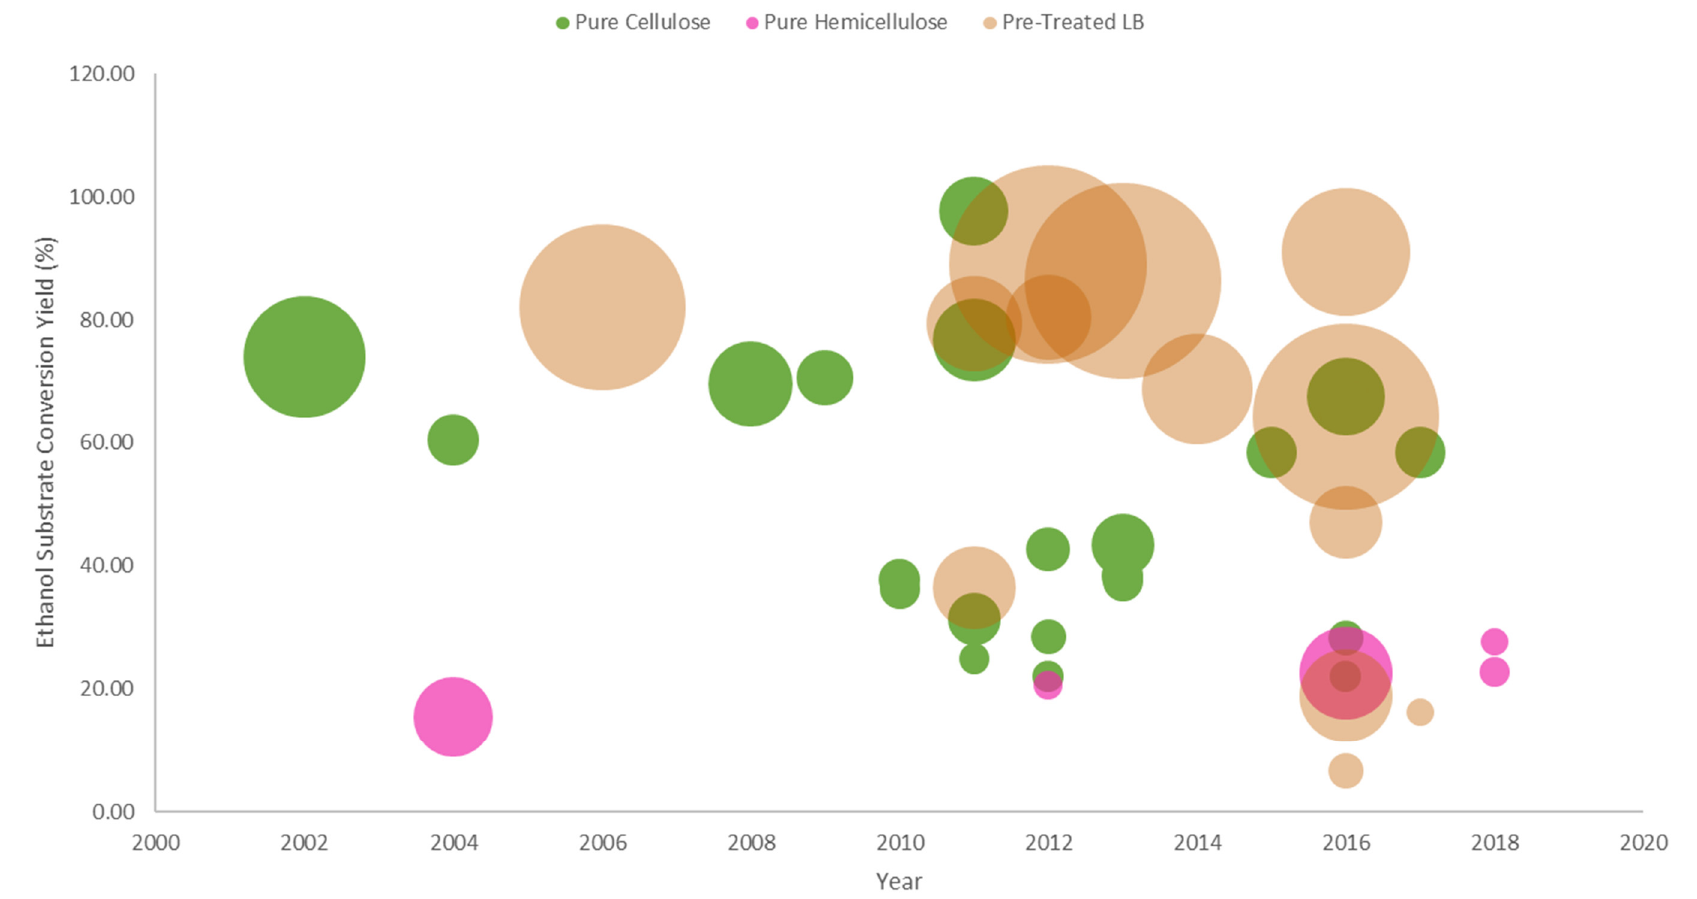
Figure 9. Visualization of the status and development of yeast surface display for Bioethanol Production categorized for the substrate types presented in this article. Bubble sizes represent ethanol titer.